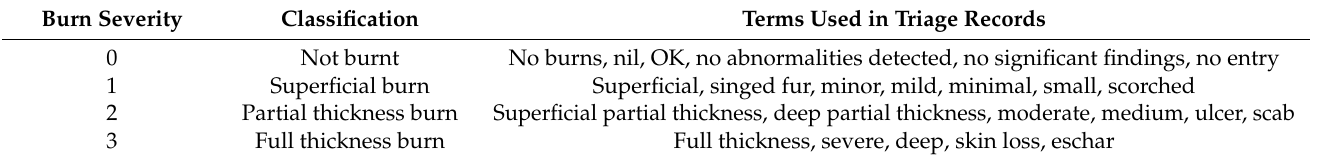
Table 3. Burn severity classification based on descriptions used in triage